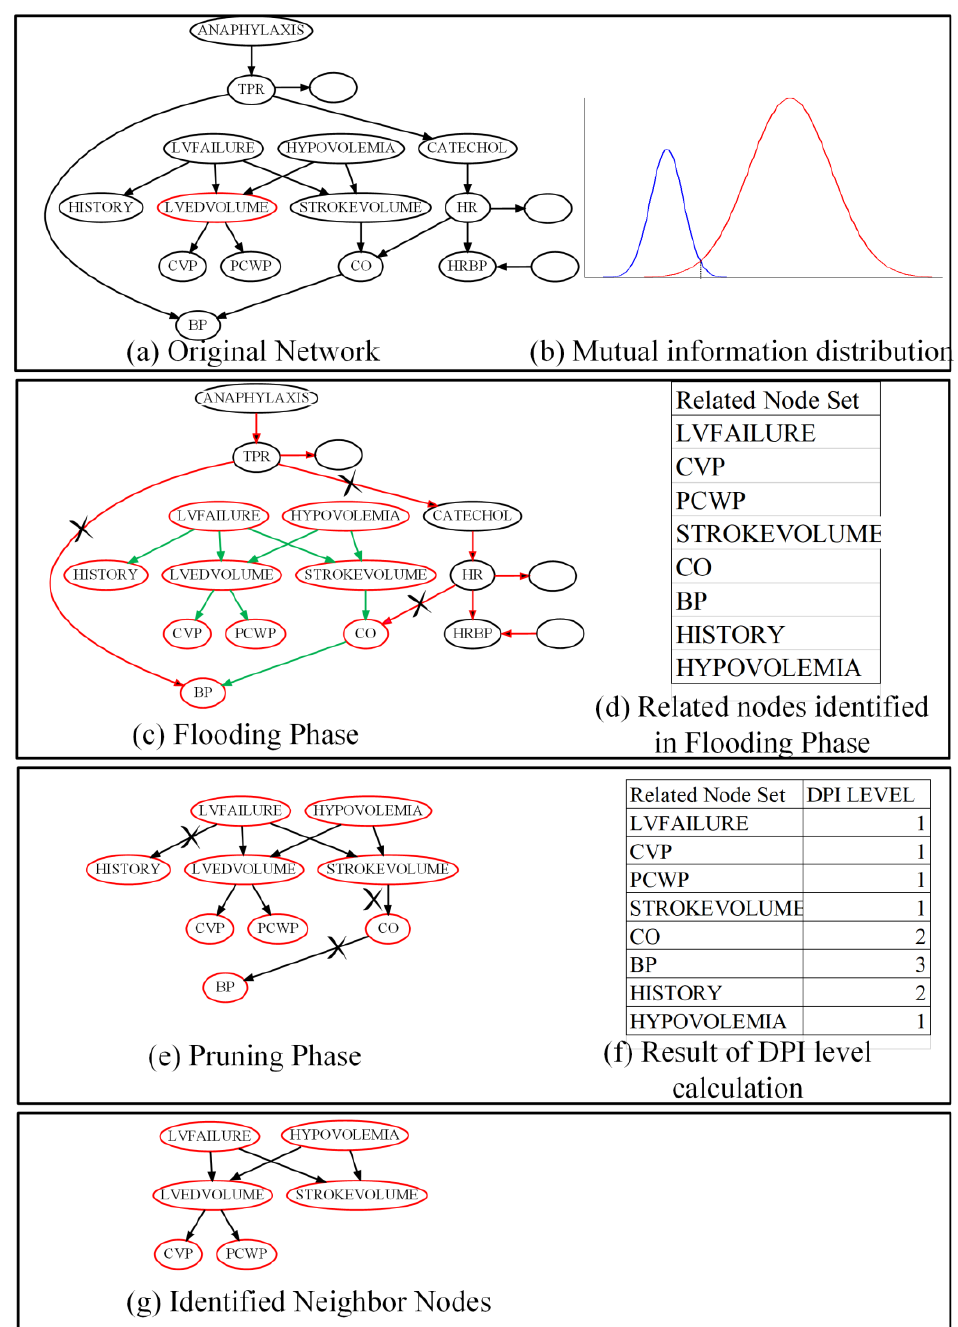
Figure 3. The example trace of Flooding-Pruning Hill Climbing (FPNS). DPI: data processing inequality.